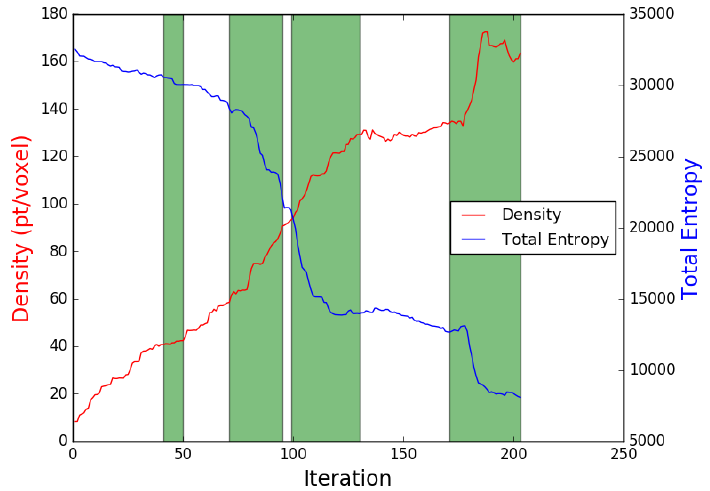
Figure 11. The density and total entropy attributes along the iterations during the power plant coverage using the proposed Guided NBV. The areas where the viewpoints generator switched to FVS are shown in